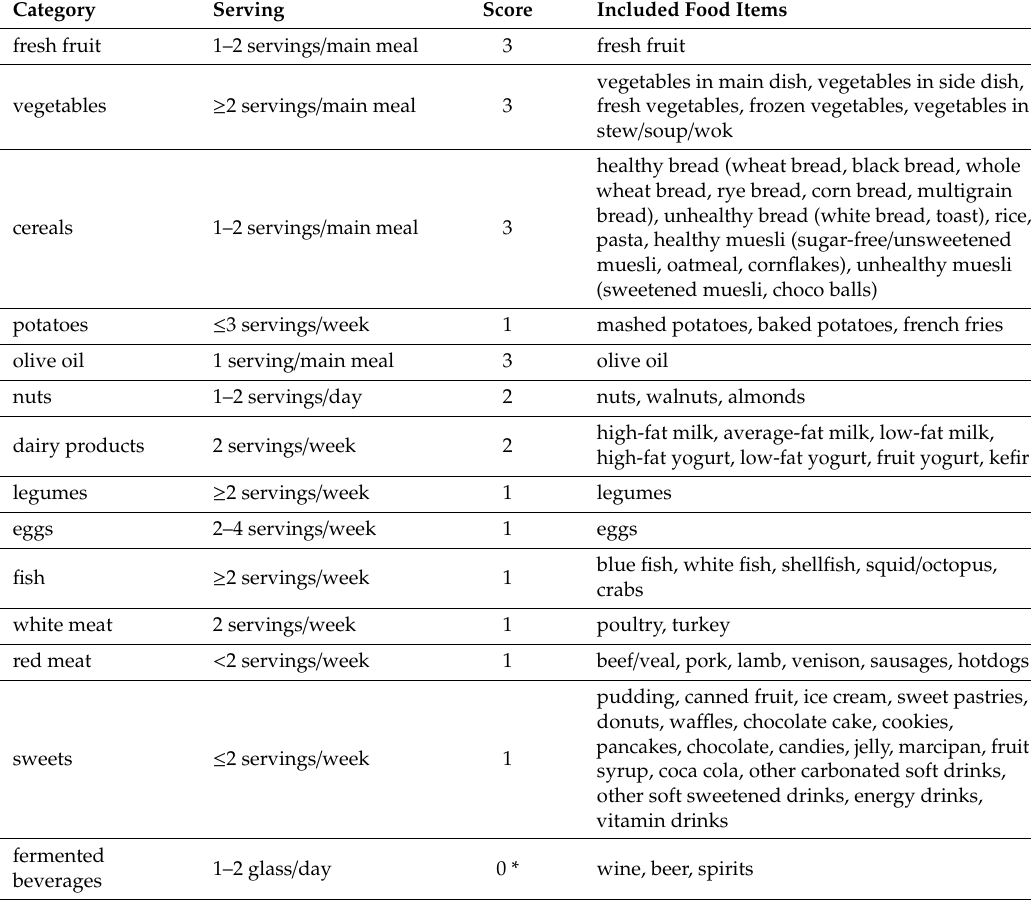
Table 1. Food categories used for the calculation of the Mediterranean Diet Serving Score